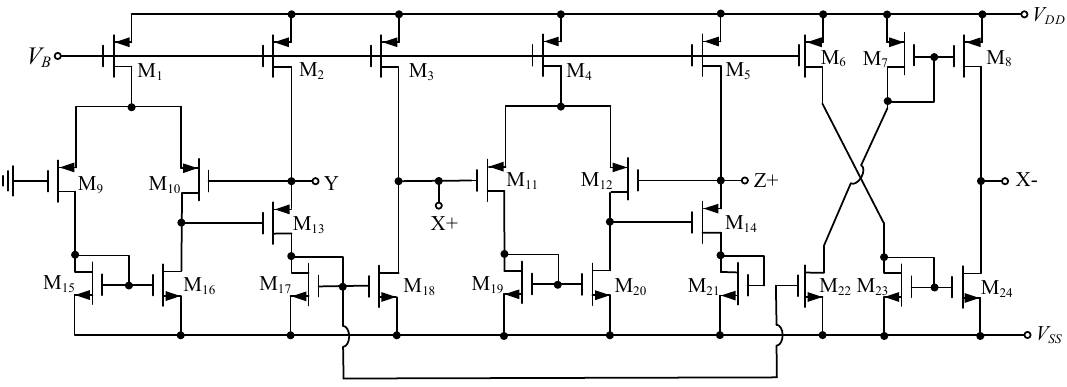
Figure 5. Internal structure of the used VCII± without Z − terminal. Table 1. Some performance parameters of the VCII± of Figure 5.